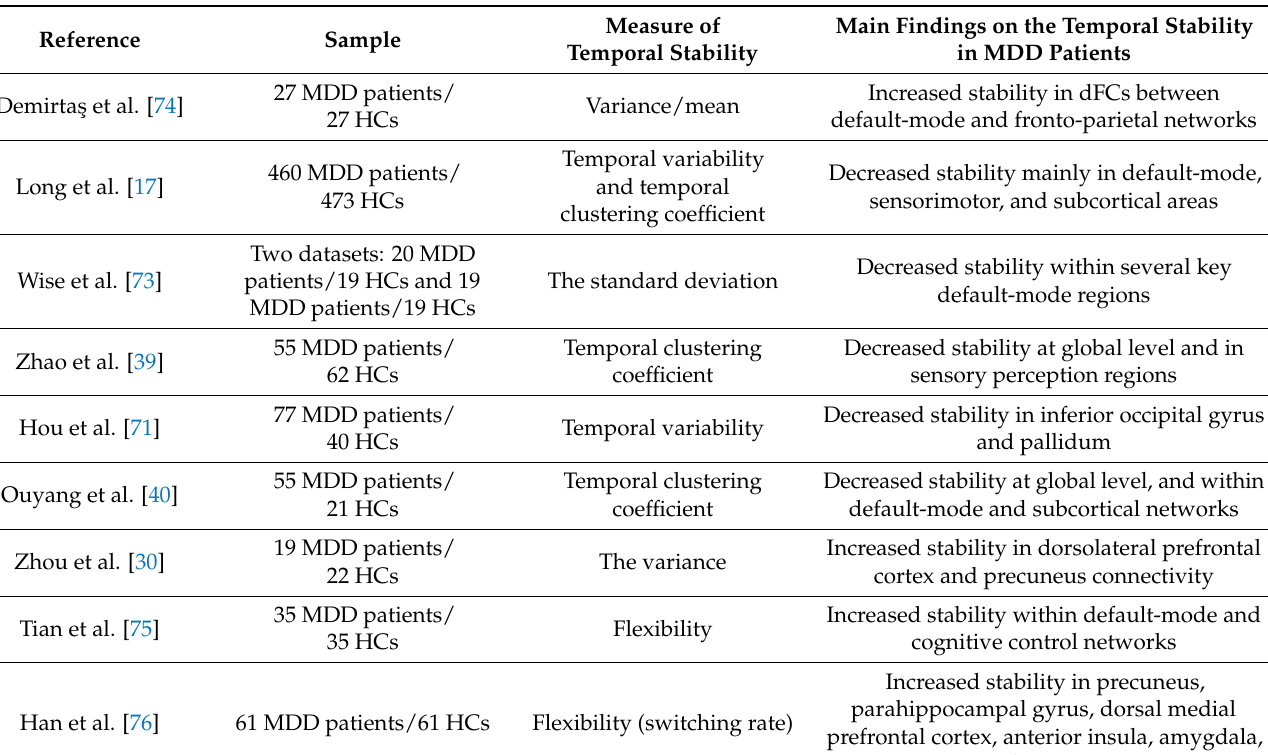
Table 2. Summary of main findings of changes in the temporal stability of brain network in patients with major depressive disorder (MDD) as mentioned in this manuscript. HCs, healthy